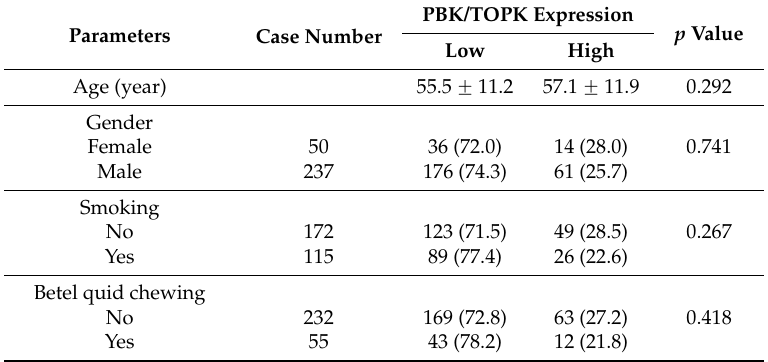
Table 1. Relationships between PBK/TOPK (PDZ-binding kinase/T-LAK cell-originated protein kinase) expression and clinical parameters in 287 oral cancer